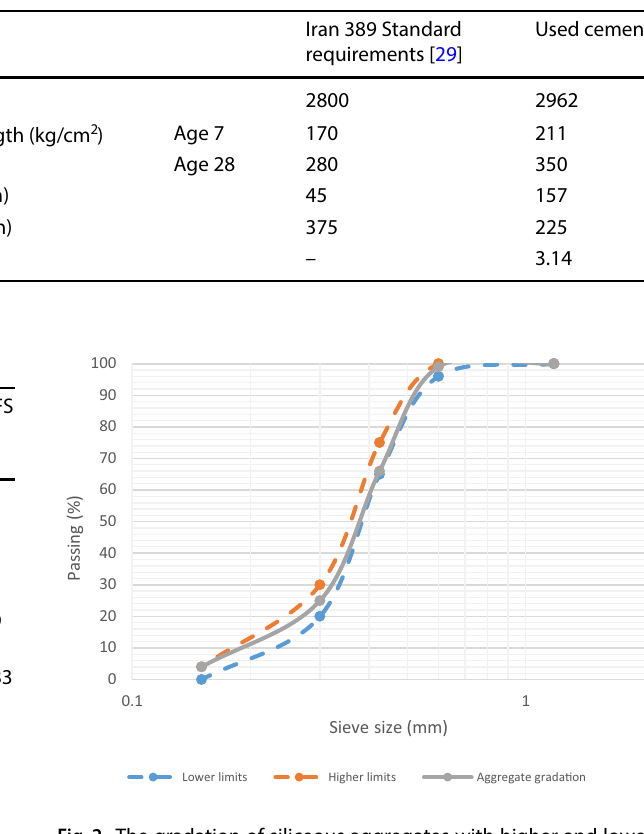
Fig. 2 The gradation of siliceous aggregates with higher and lower